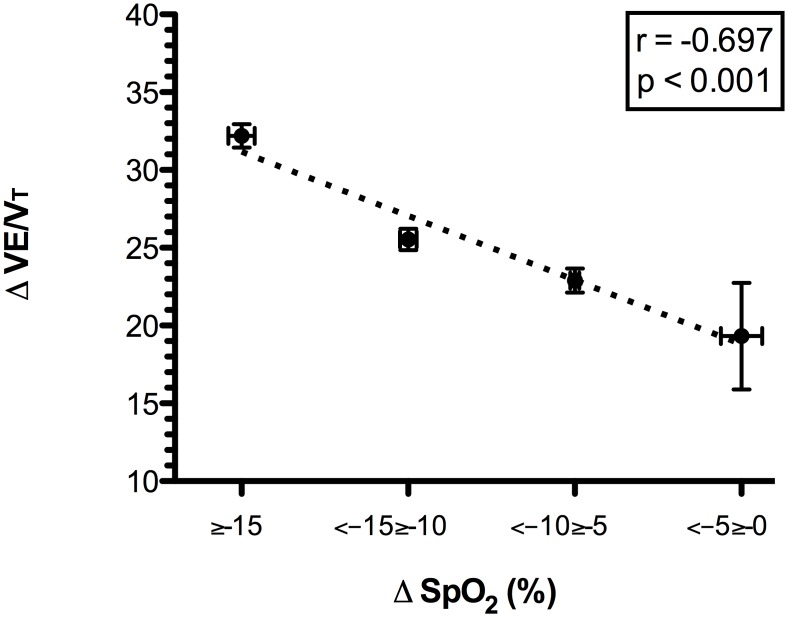
Relationship between the delta VE/VT ratio and the mean decrease in oxygen saturation during the run.Reductions in SpO2 (SpO2 at rest—mean SpO2 during the race) were grouped into four classes, each associated with the delta VE/VT (difference between VE/VT ratio during the run and at rest). Increases in the VE/VT ratio were related to greater levels of oxygen desaturation. Abbreviations: Δ SpO2, mean decrease in oxygen saturation; VE/VT, ratio between ventilation and tidal volume.